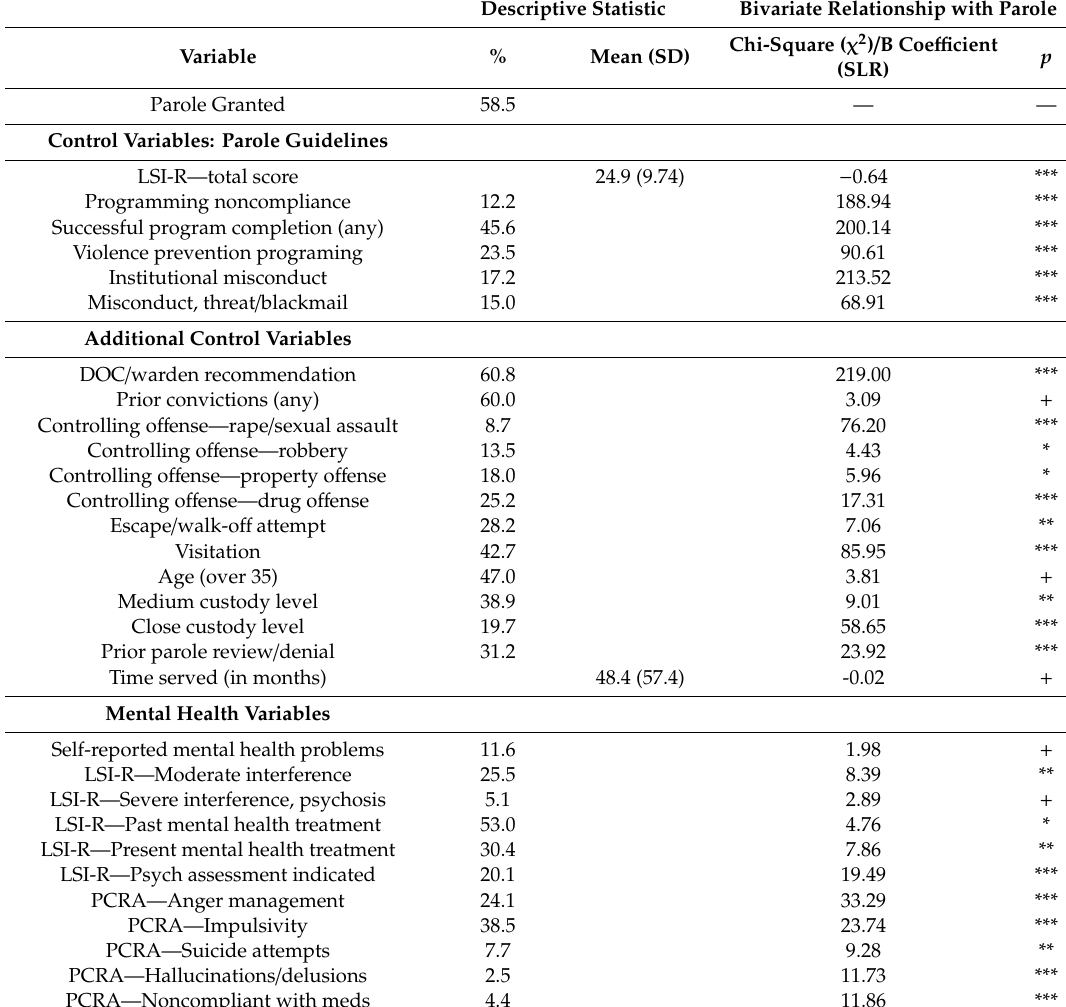
Table 2. Descriptive statistics and bivariate results for variables screened against parole